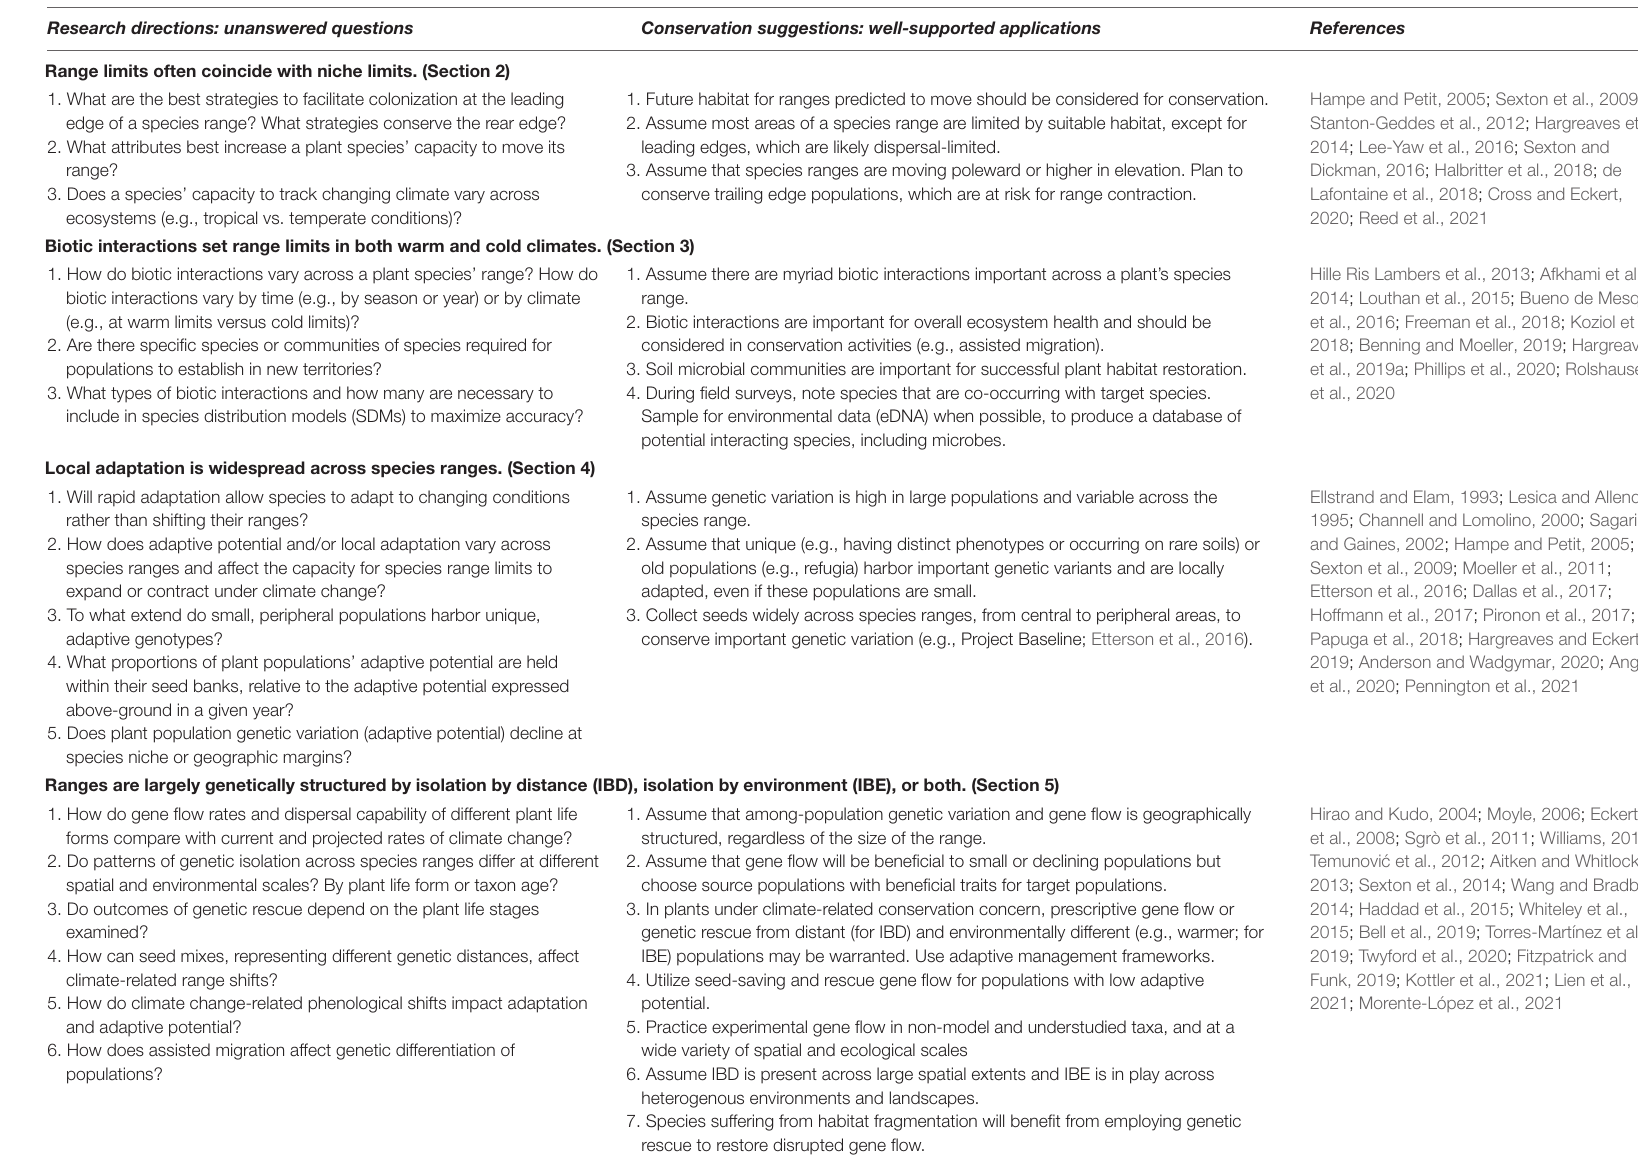
TABLE 1 | Rules of plant species ranges, their open research questions, conservation applications, and supporting